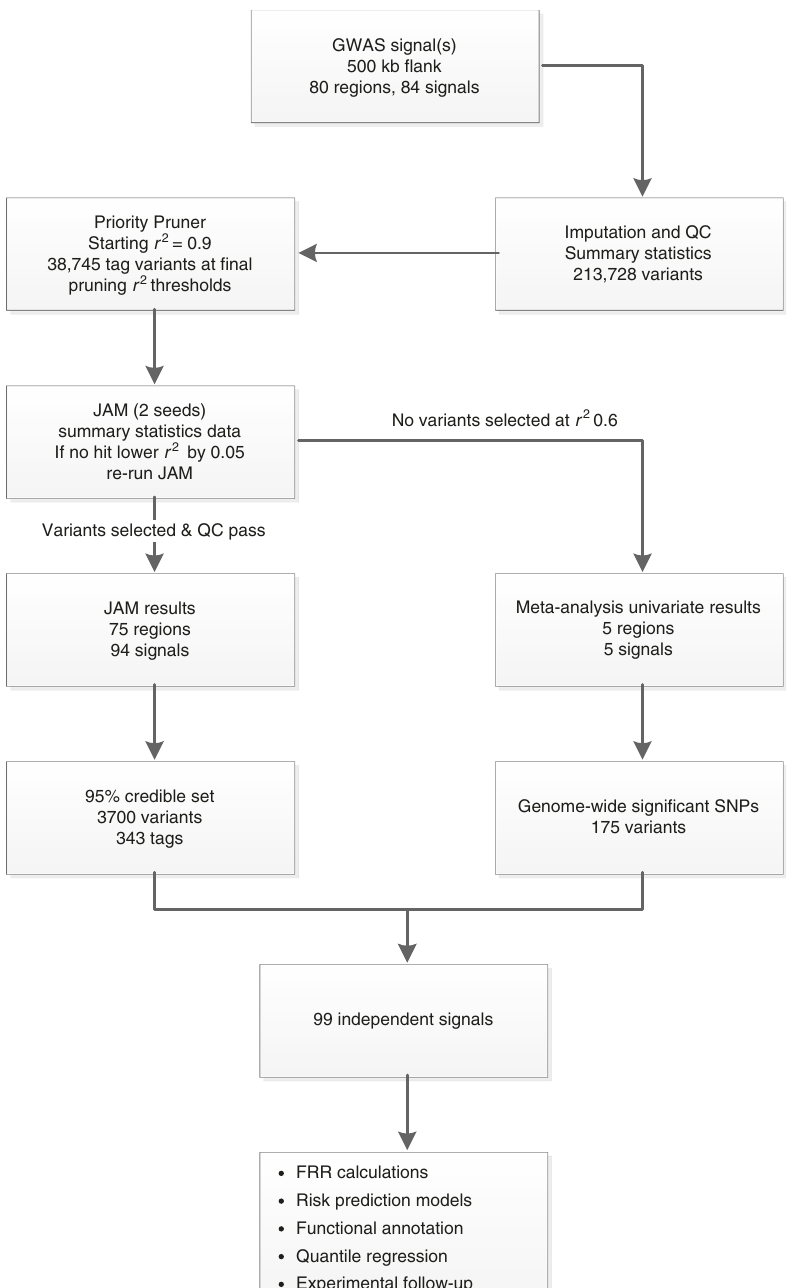
Fig. 1 Overview of the fi ne-mapping work fl ow. Flowchart describing the procedure followed during fi ne-mapping, providing an overview of the outcomes at each stage and suggesting possible applications for the fi nal catalogue of